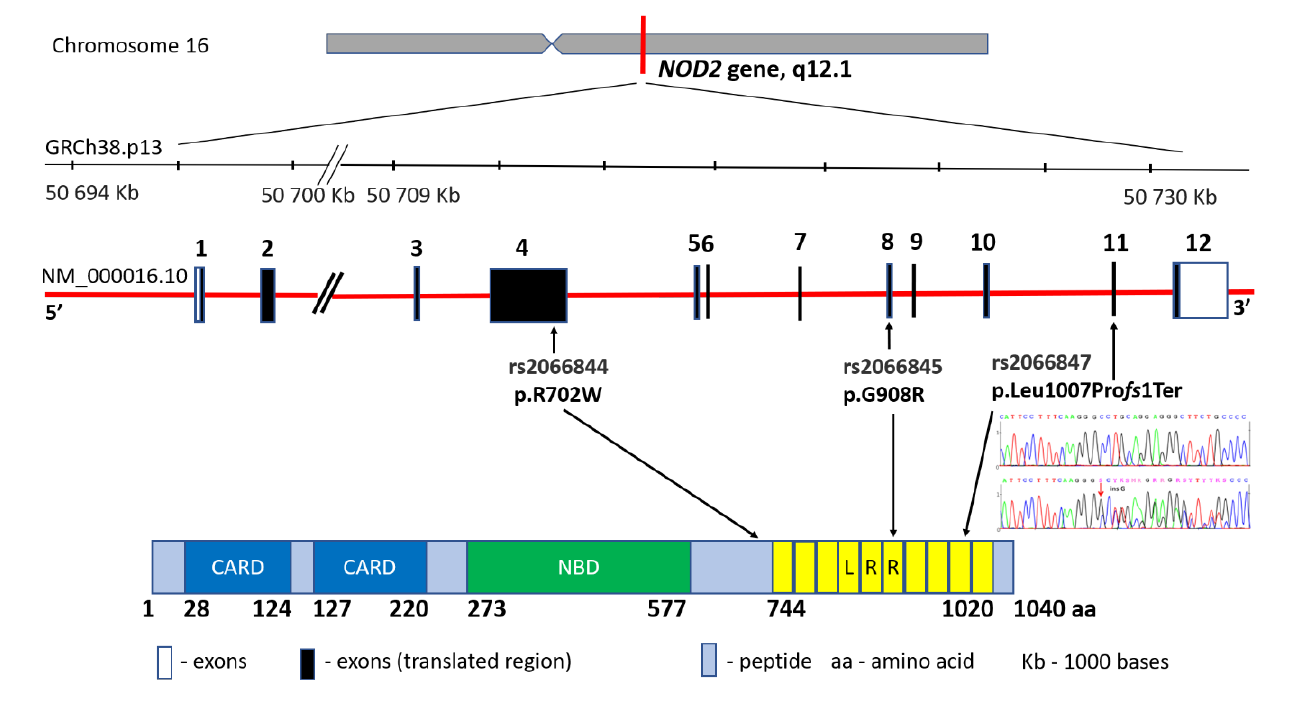
Figure 2. NOD2 gene structure, main variants’ distribution and the protein product.